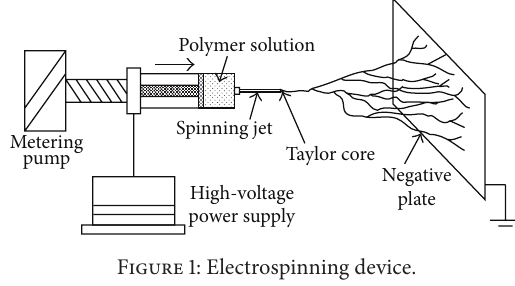
Figure 1: Electrospinning